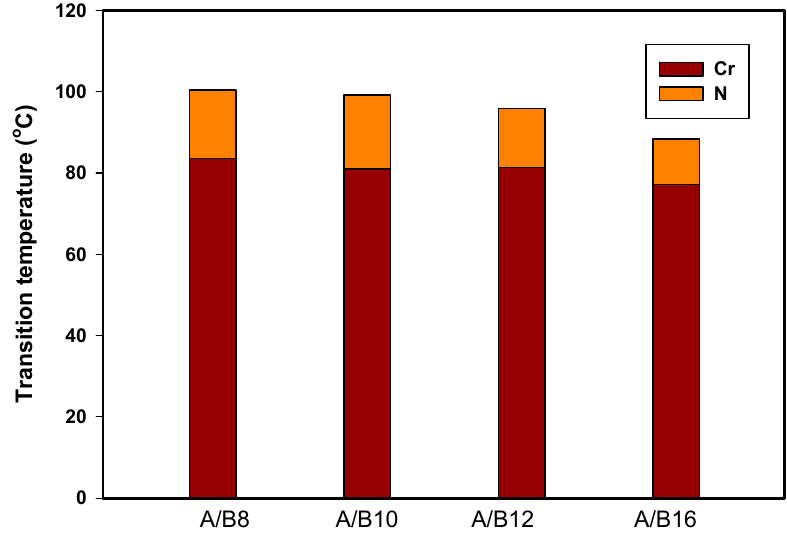
Figure 4. DSC transitions of 1:2 HBSMCs series, A/2Bn.